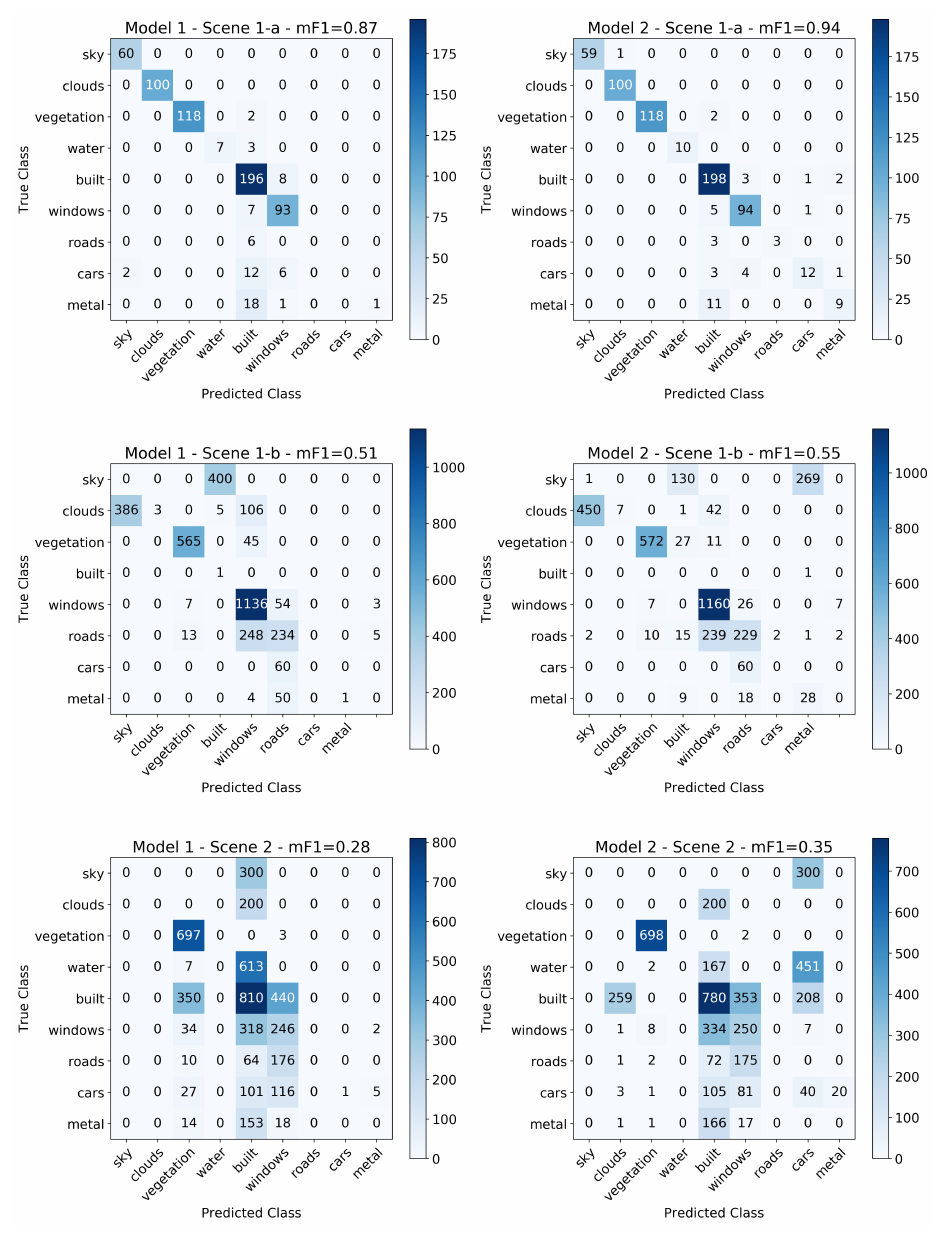
Figure A4. Confusion matrices used to derive the metrics in Table 4 for the classification of hand-labeled pixel spectra using Model 1 ( left ) and Model 2 ( right ) trained on Scene 1-a, and transferred to Scenes 1-b and